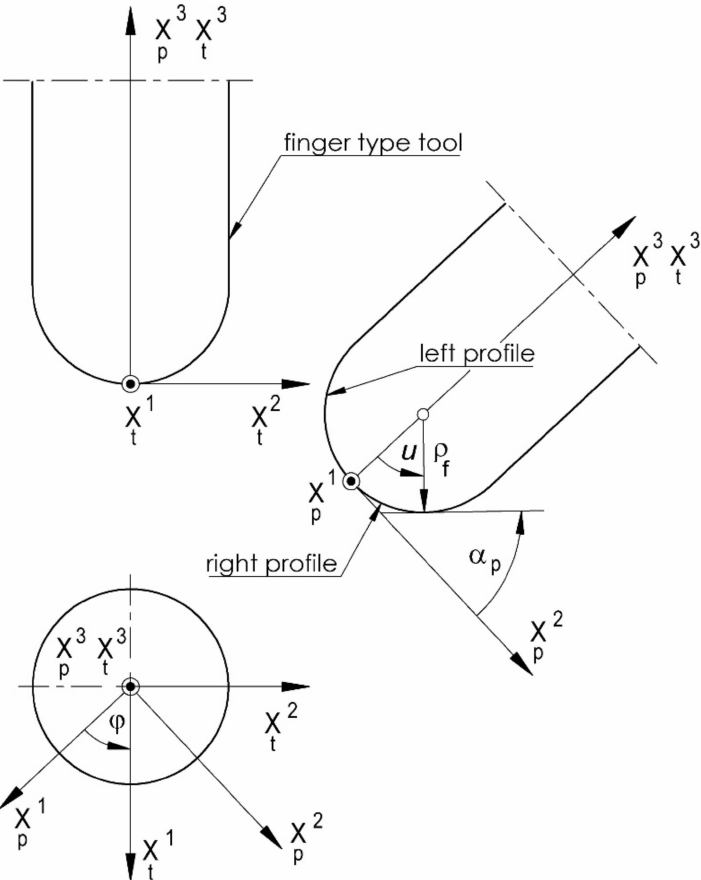
Figure 1. The form of the definition of the tool-action surface axial